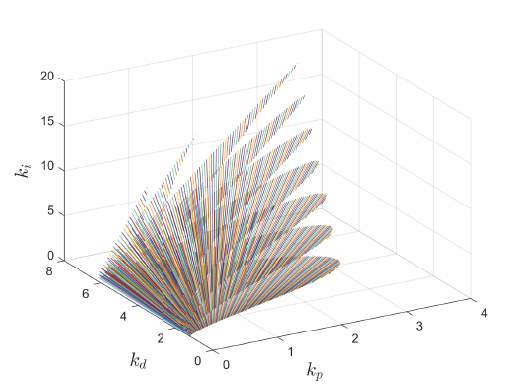
Figure 9. Feasible PID parameter region of the plant (Equation